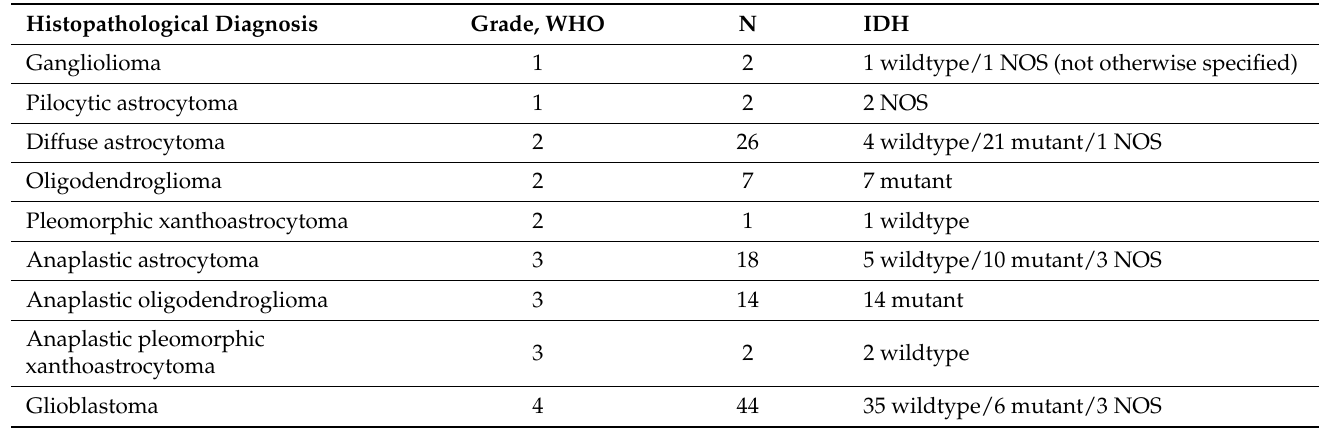
Table 1. Tumor distribution in the study